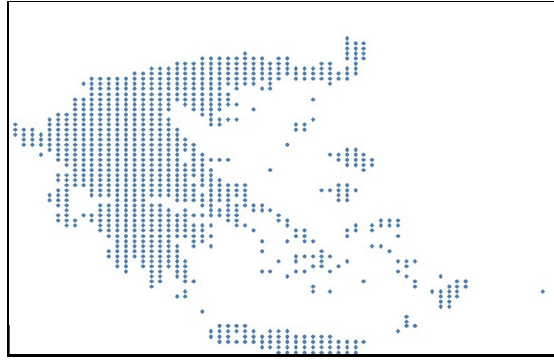
Figure 6. Real dataset from Greece.